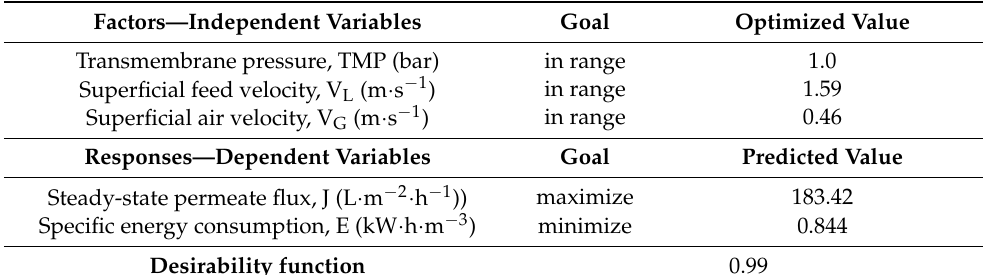
Table 4. Optimization results obtained by the desirability function approach during SMGS microfil- tration of Bacillus velezensis IP22 cultivation